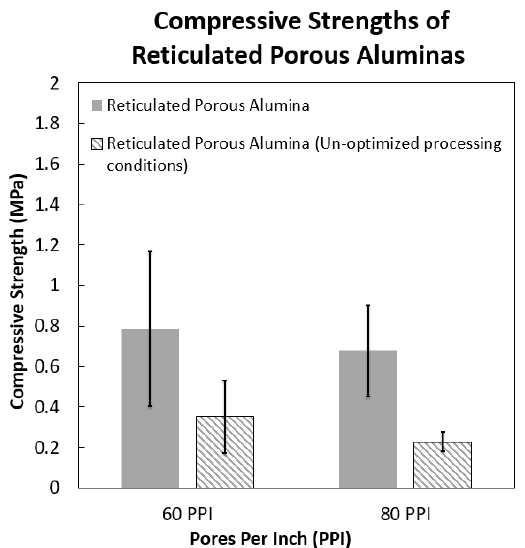
Figure 1. Compressive strengths of the reticulated porous alumina specimens with pore densities of 60 and 80 PPI, which were prepared using the optimized and the un-optimized processing conditions,